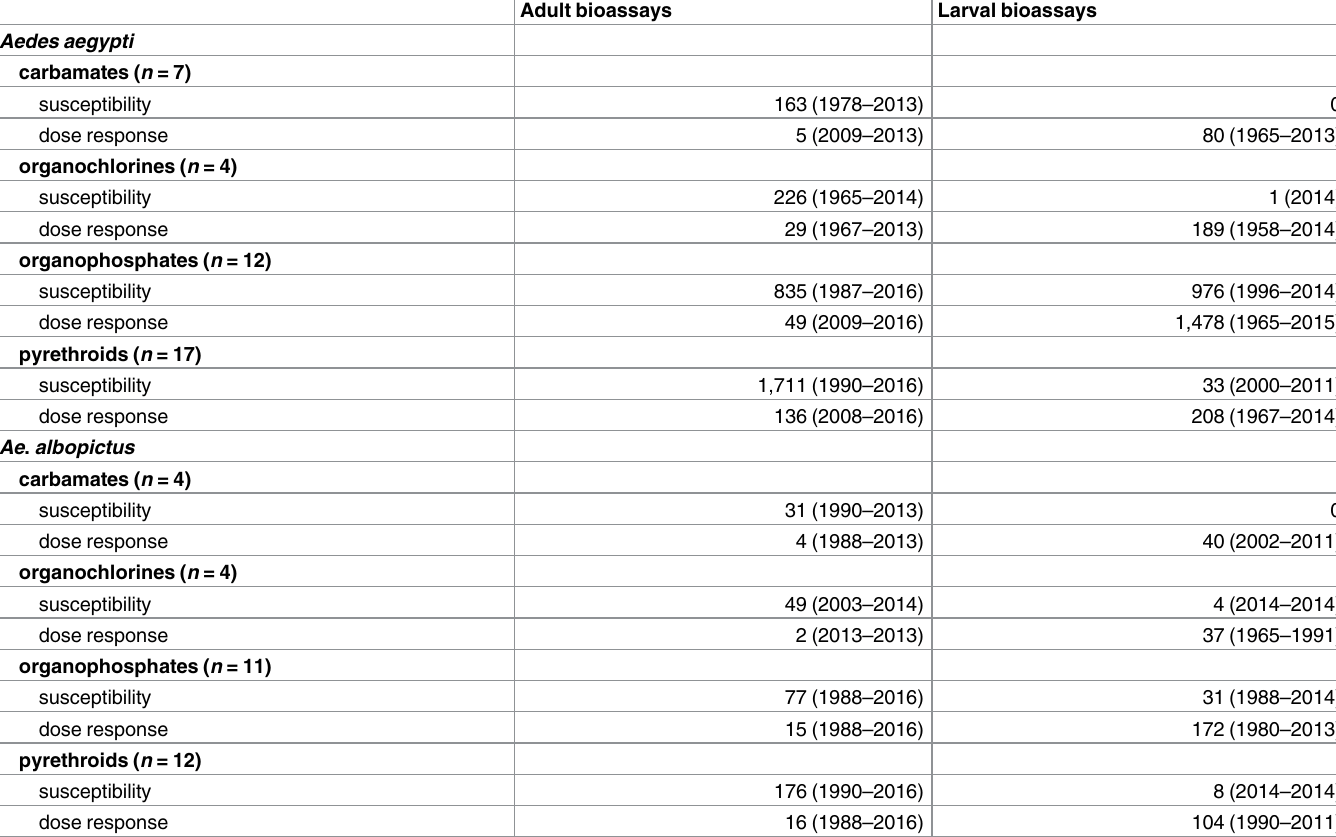
Table 1. Number of bioassay records for each test